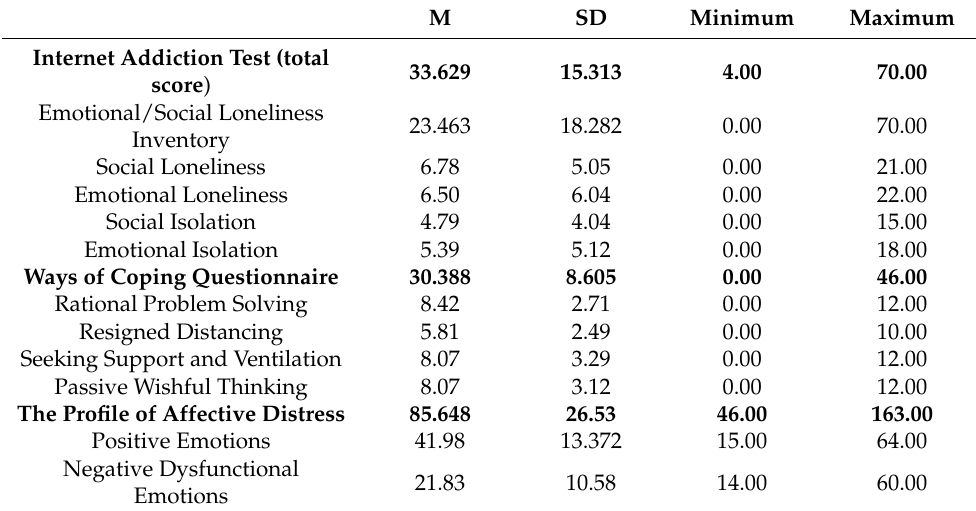
Table 1. Means and standard deviations for the measured